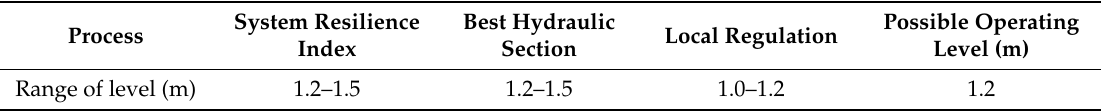
Table 3. DR operating level based on the system resilience index, best hydraulic section and local